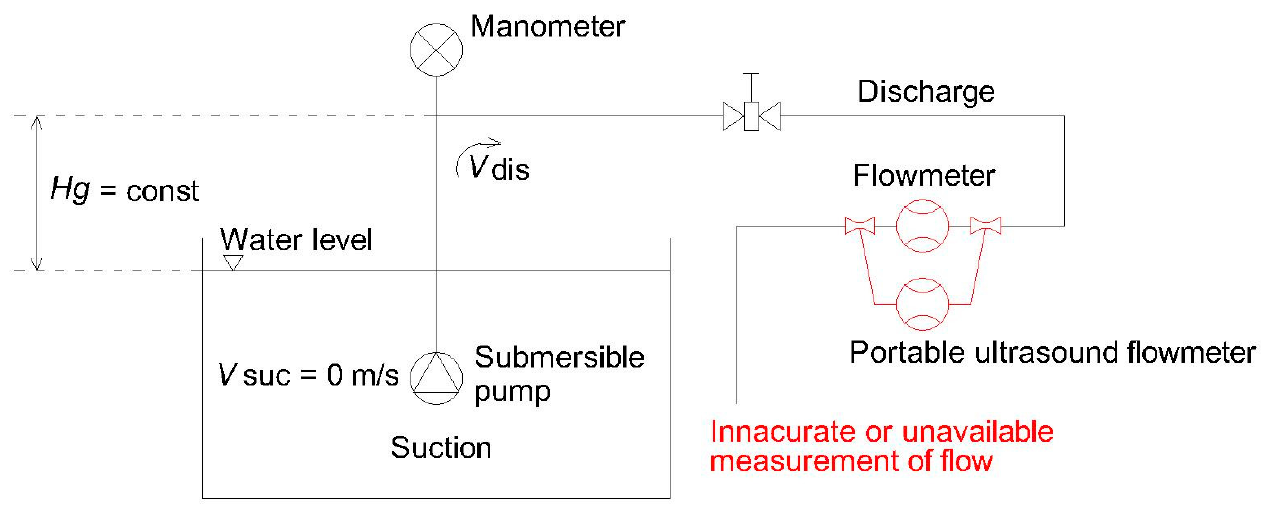
Figure 1. The layout of the elements required for flow rate estimation.